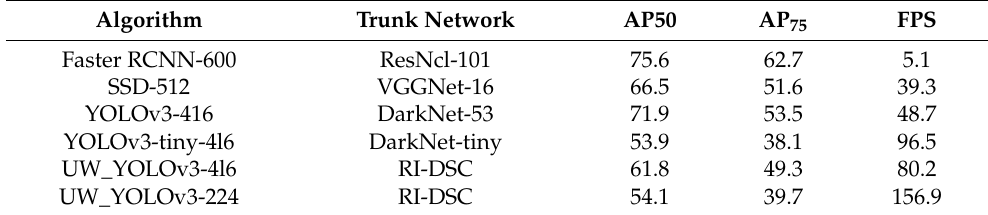
Table 3. Comparison of the detection effects of different algorithms.